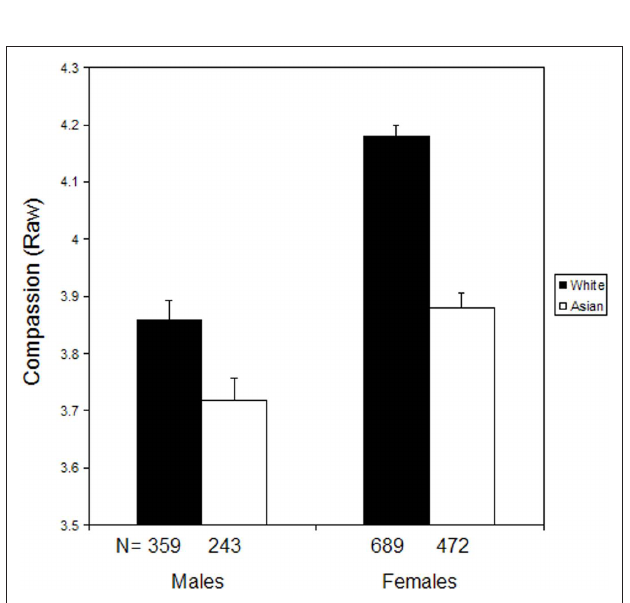
FIguRE 2 | Ethnicity moderates gender differences in Compassion.